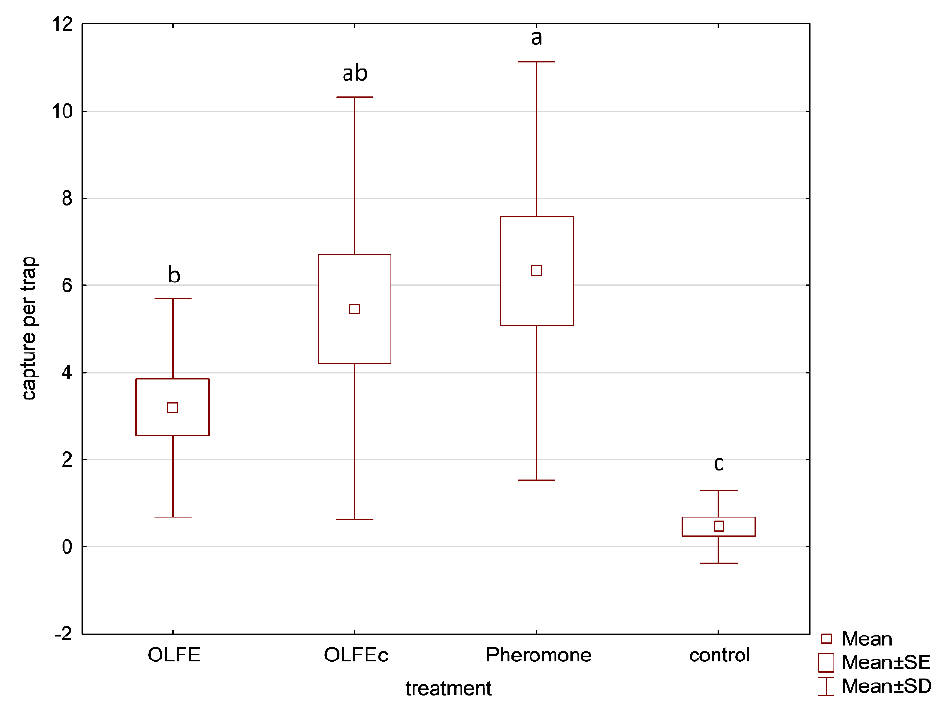
Figure 3. Number of male CPB captured in delta traps baited with OLFE, concentrated OLFE (OLFEc), pheromone lures (USDA), and unbaited control traps. Tests were conducted at the Insitu field site and the MCRC site with a total of fifteen replicates per treatment. Kairomone treatments consisted of 20 ml samples in the specialty black membrane formulation. Boxes presenting different letters are significantly different.